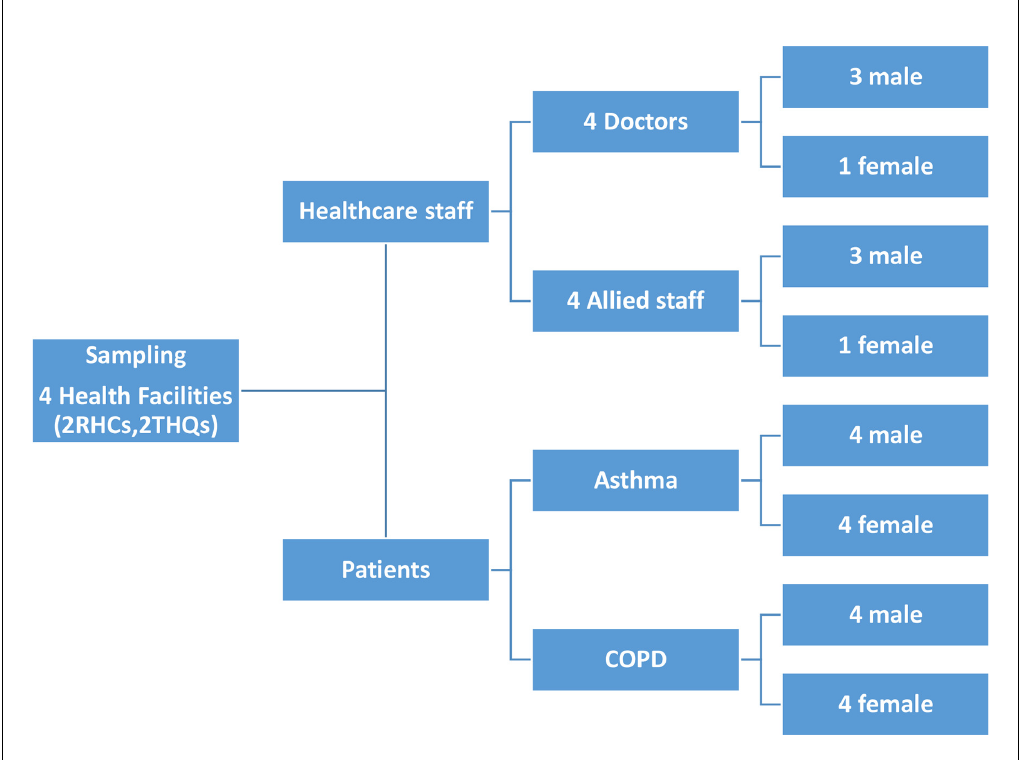
Figure 1. Sampling for interviews COPD = chronic obstructive pulmonary disease. RHC = rural health centre. THQ = Tehsil